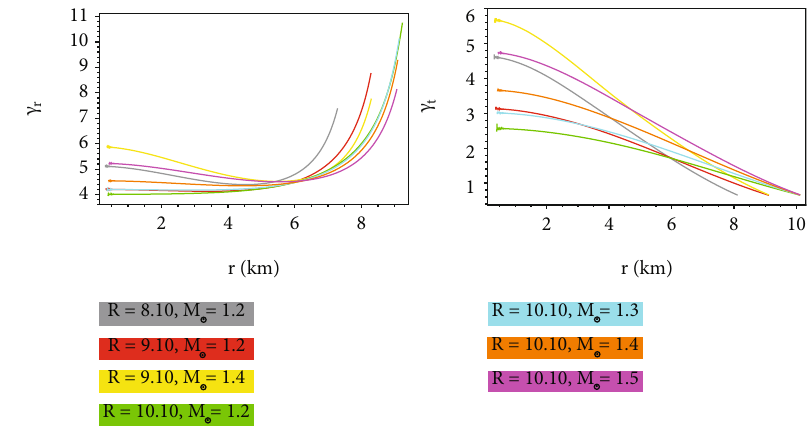
Figure 11: Variation of γ